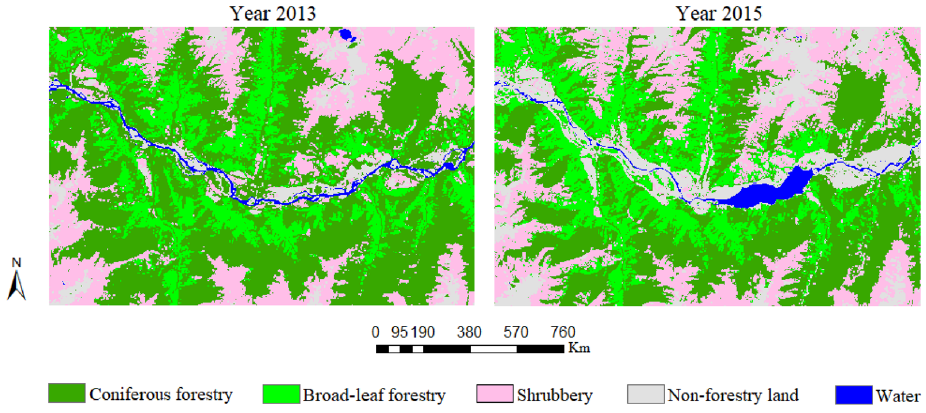
Figure 2. The maximum likelihood classification results of 2013 and 2015. The figure is generated using ArcGIS 10.3 (http:// www. esri. com/ softw are/ arcgis/ arcgis- for- deskt op).